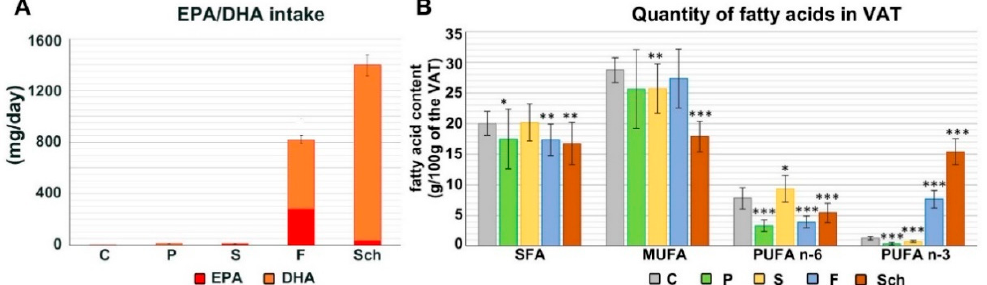
Figure 1. Fatty acid intake and deposition of fatty acid in target tissue. ( A ): EPA/DHA daily intake (EPA in red, DHA in orange) from individual diets: a standard diet alone (control, C), or a standard diet enriched with 8% of palm oil (P), safflower oil (S), fish oil (F) and Schizochytrium extract (Sch). ( B ): Fatty acid deposition in the visceral adipose tissue (VAT). Stars labeled group of fatty acids differ significantly from the control group (* p < 0.05; ** 0.01 < p < 0.05; *** p < 0.001; unpaired t -test; n = 10), average values and standard deviations are displayed in these graphs.